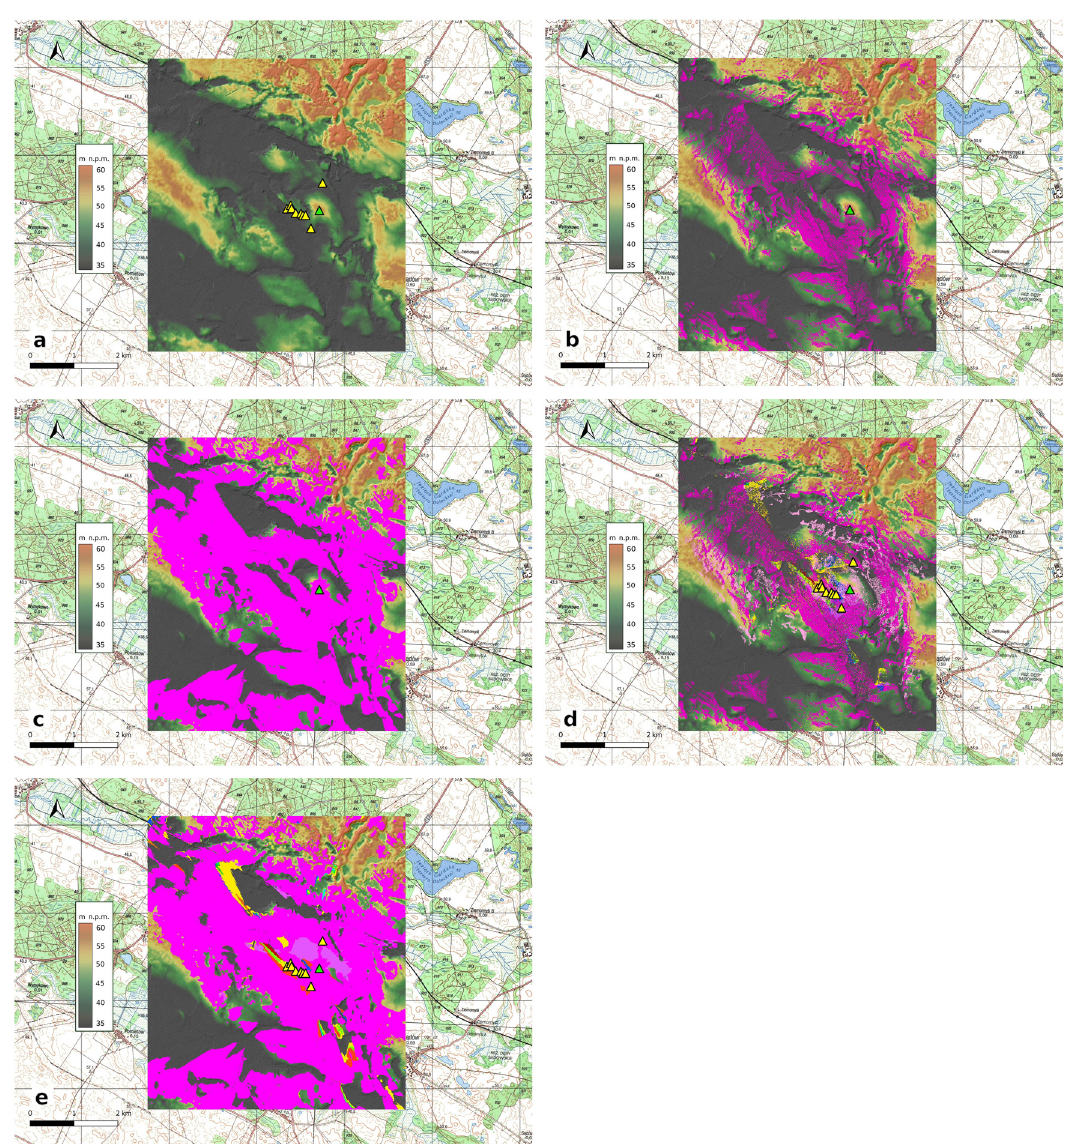
Figure 20: The point selected as optimal near the Dolice - Komorowo South megalithic group ( yellow triangle ) in terms of visibility from this location and this location from the surrounding area: location of the point [ green triangle ] ( a ) , the area visible from the point ( b ) , the area from which the point is visible ( c ) , the juxtaposed areas visible from the point and the tombs of the Dolice - Komorowo South megalithic group ( d ) and the juxtaposed areas from which the point and the tombs of the Dolice - Komorowo South megalithic group are visible ( e ) ( M. Schiller )